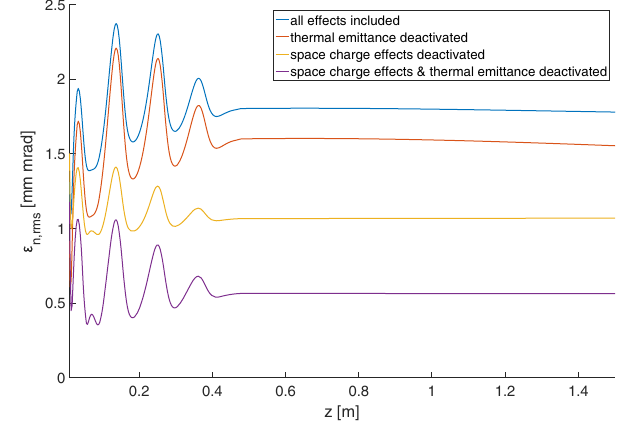
FIG. 9. Results of tracking a 100 pC electron bunch through the ELBE SRF Gun with different emittance contributions generated with A STRA . The bottom purple curve shows the baseline contribution of the rf field itself.